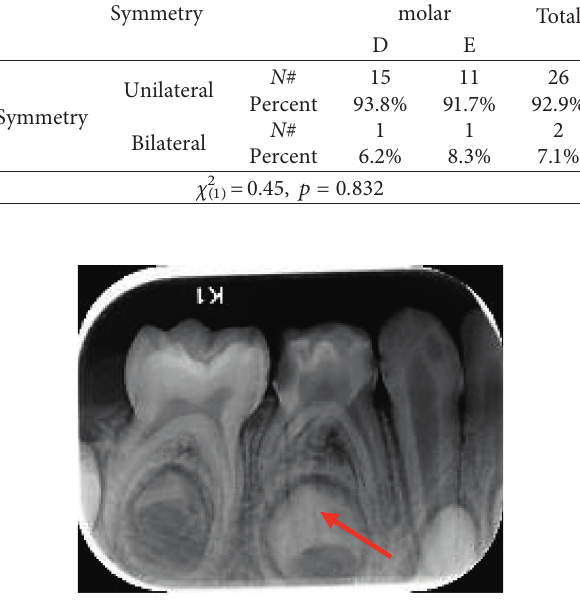
Figure 1: Intraoral periapical radiograph showing third root in right mandibular first primary